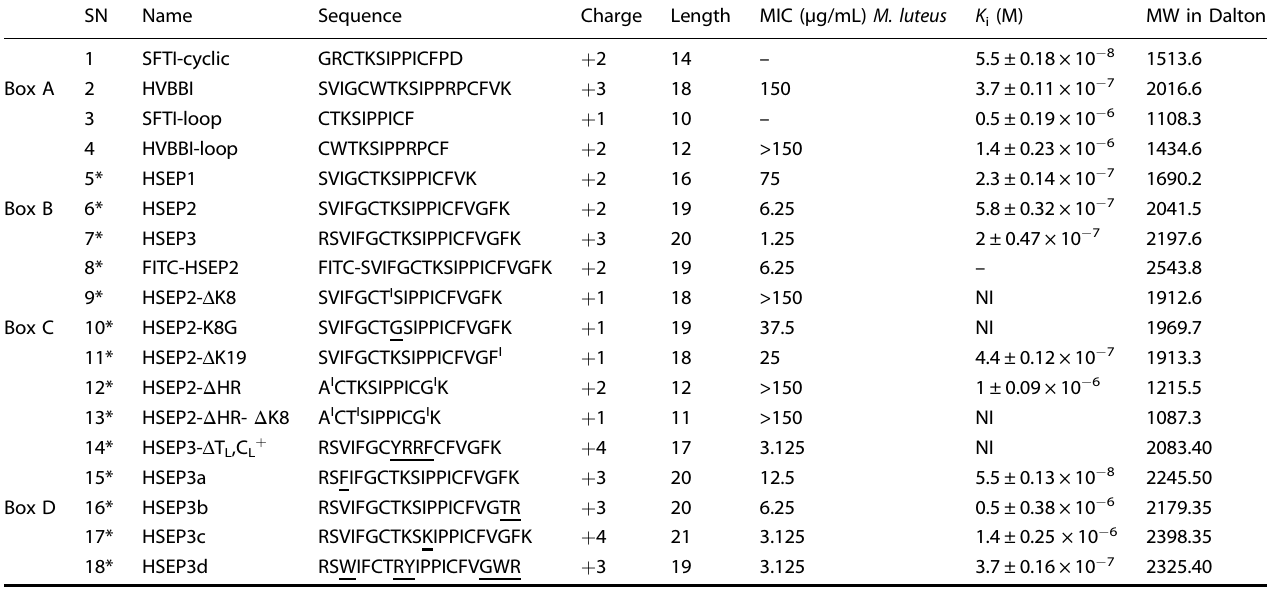
Table 1. Peptides used in this study. Amino acid sequences, molecular weights, net charges, length, MICs (against M. luteus ) and Ki values (against bovine trypsin) of the tested peptides.